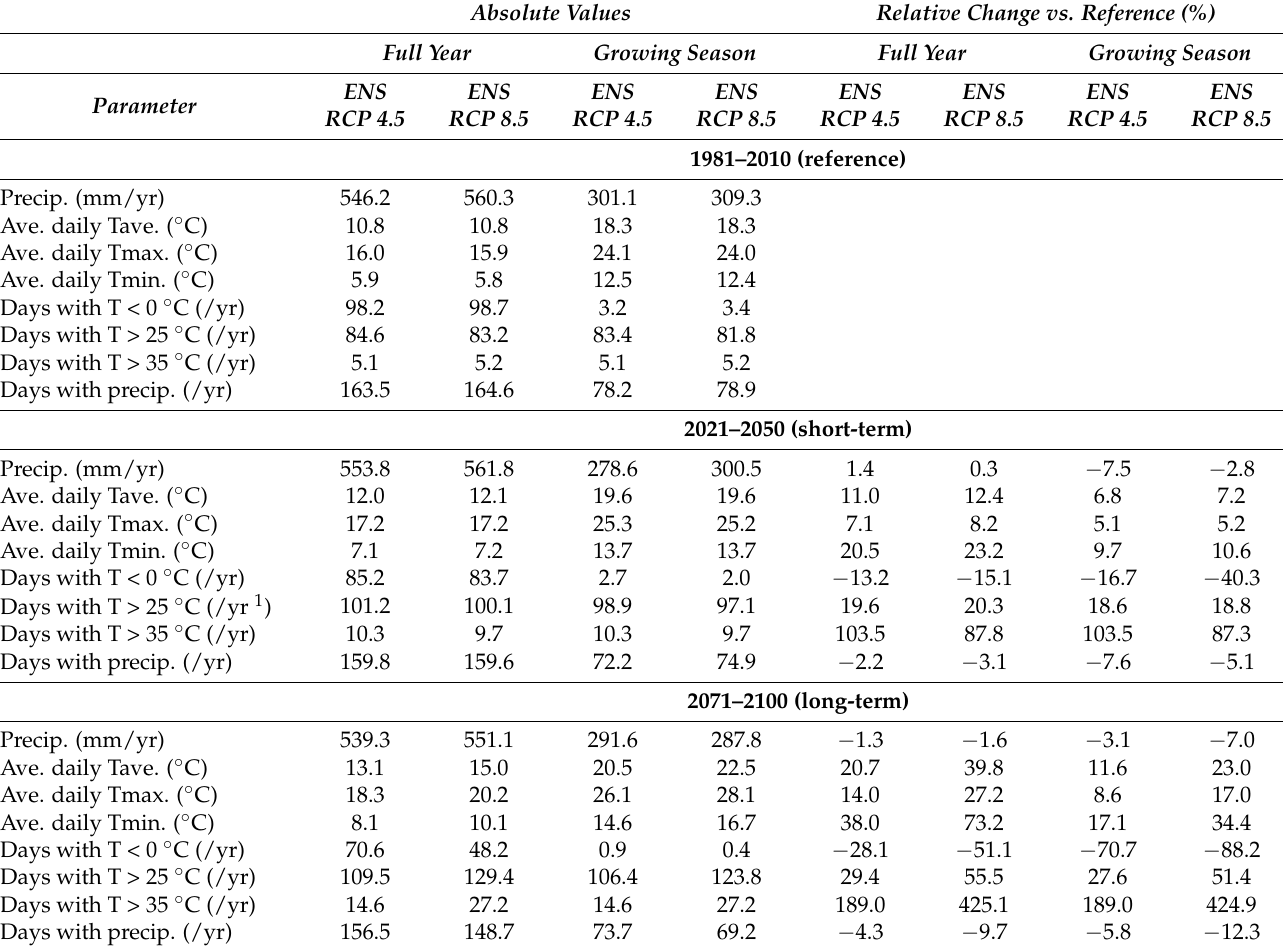
Table 2. Average values for temperature, precipitation, and associated climate indicators for each climate model ensemble output for the reference, short- and long-term period (catchment scale). Absolute Values Relative Change vs. Reference